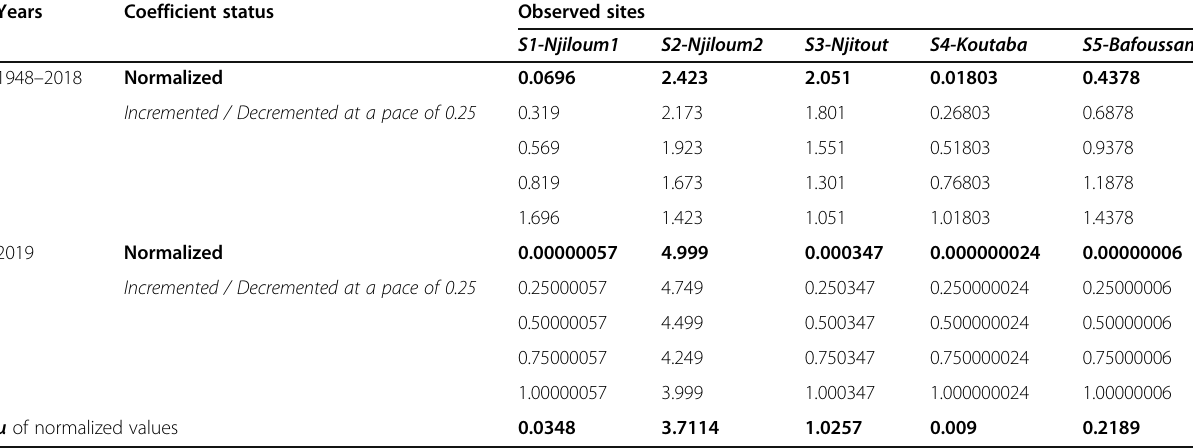
Table 7 Normalized and incremented/decremented coefficients